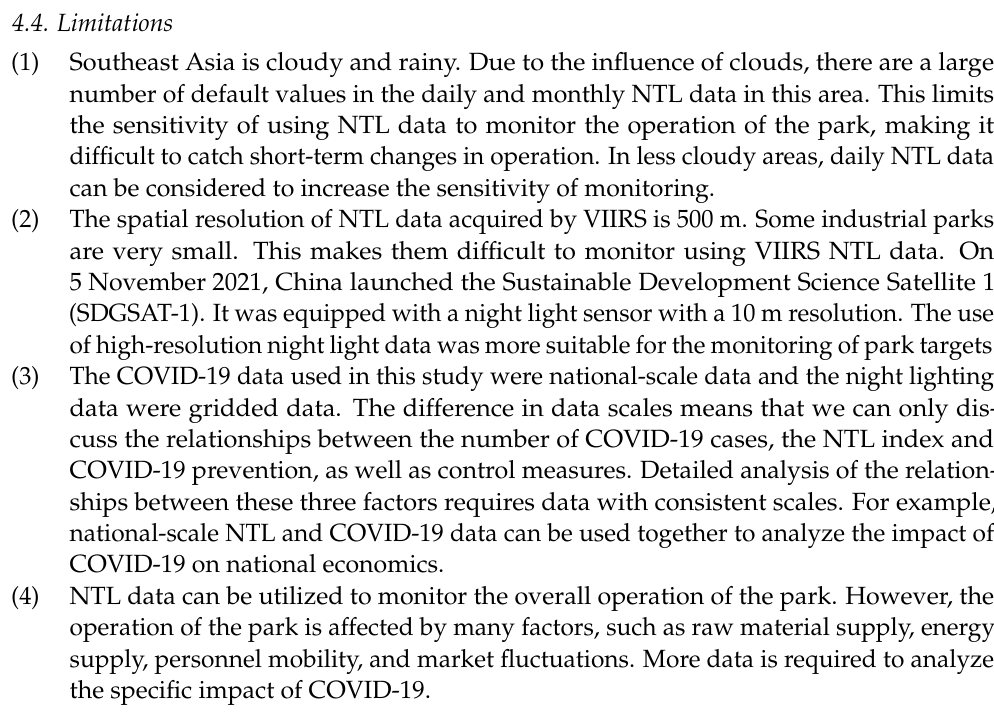
Table 6. Comparison of the impacts of COVID-19 on rural and urban parks and buffer zones. Area Parameter Rural Urban Affected number 3 8 Mean NTL_BA_D 40.03% 20.47% Parks Mean Max ( NTL_Y_D ) 47.72% 28.11% number of NTL_Y_R i > 1 3 8 Affected number 3 9 Mean NTL_BA_D 10 km buffer zones